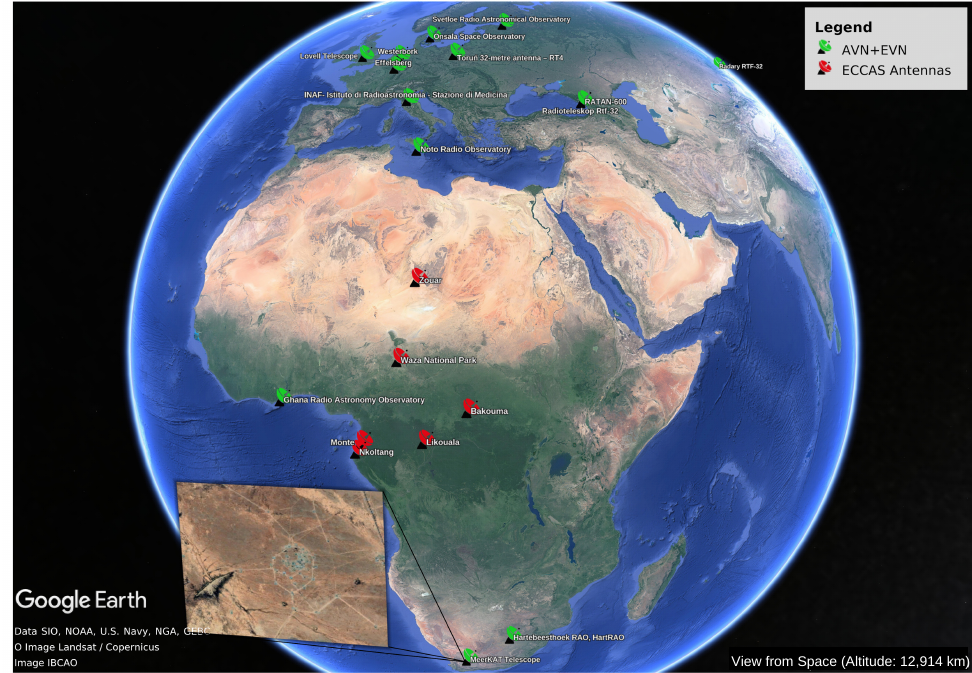
Figure 2. Green points: locations of the Kuntunse antenna in Ghana, the MeerKAT stations in South Africa, and the EVN. Red points: locations of abandoned old telecommunication satellite facilities in the ECCAS region and/or possible sites to build new radio